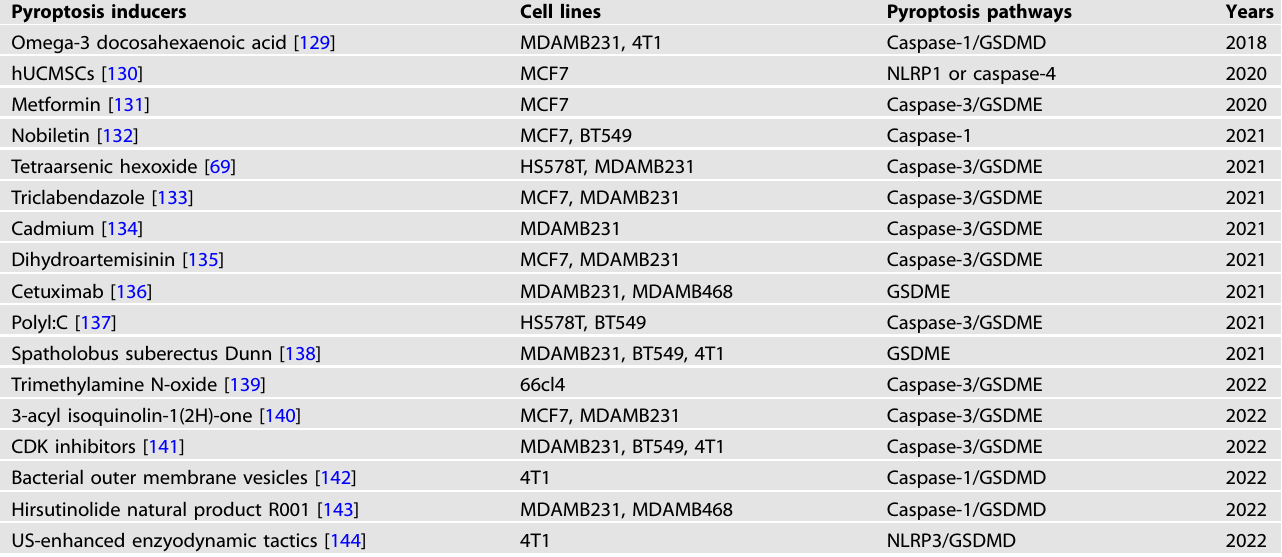
Table 2. Targeting pyroptosis in breast cancer-currently available pharmaceutical agents. Pyroptosis inducers Cell